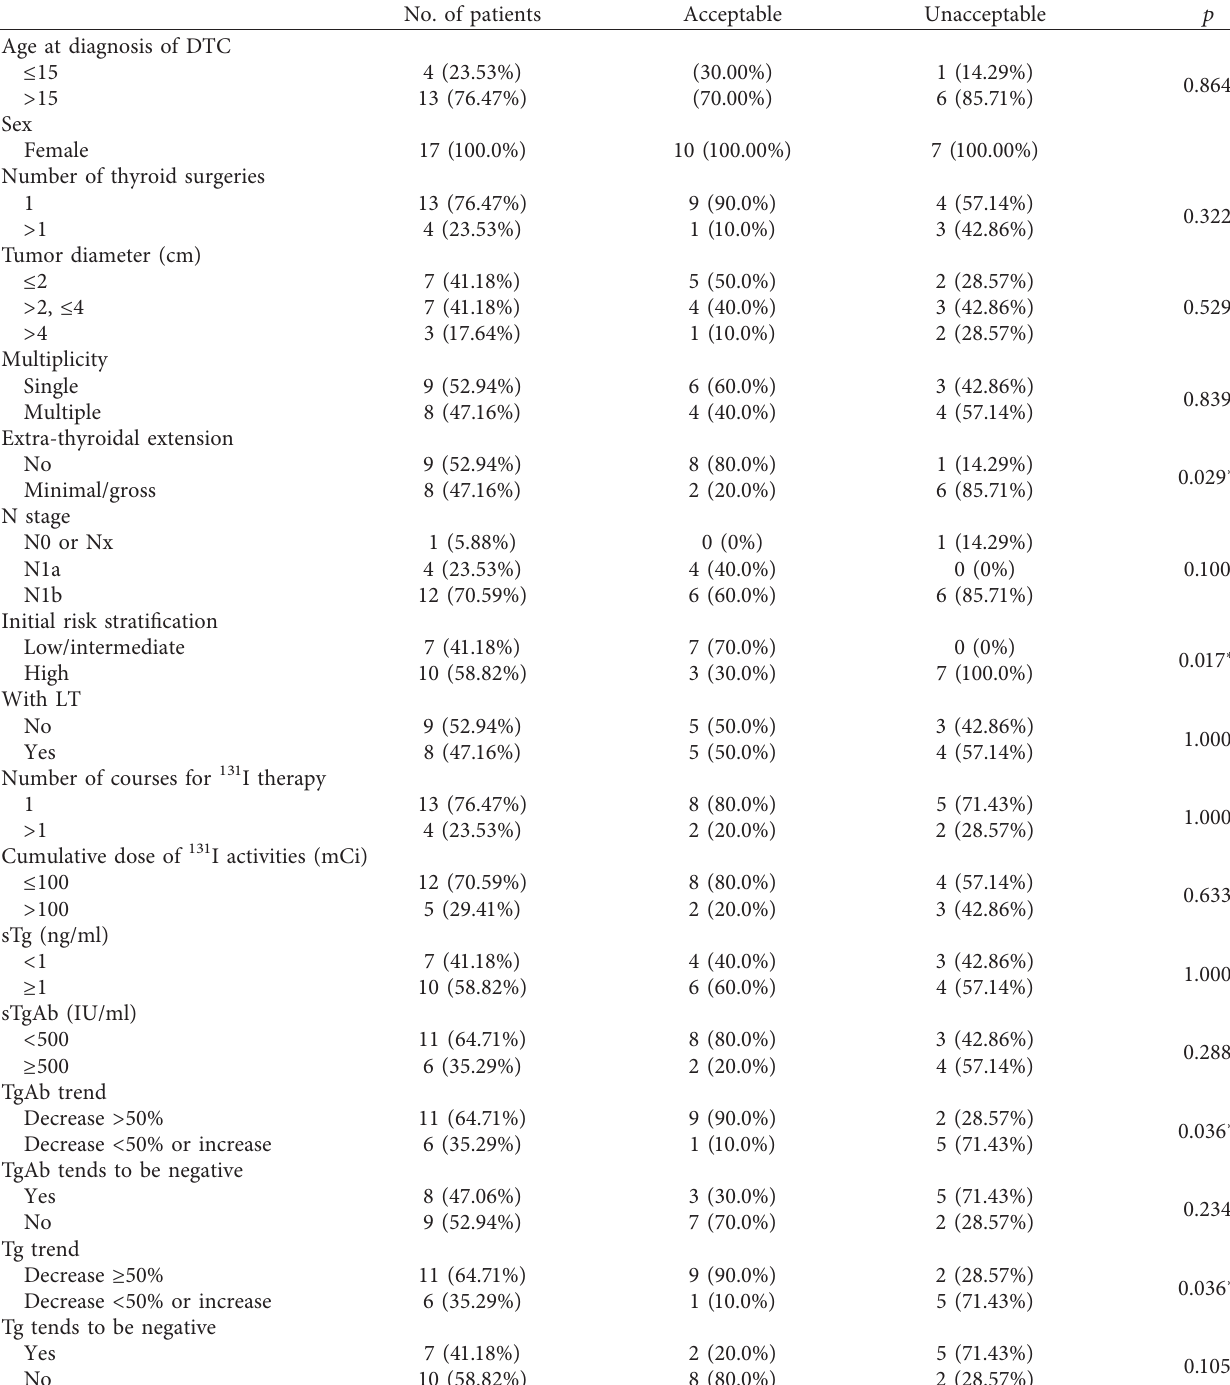
Table 4: Univariate analysis for clinicopathologic factors associated with responses to therapy in P-Tg